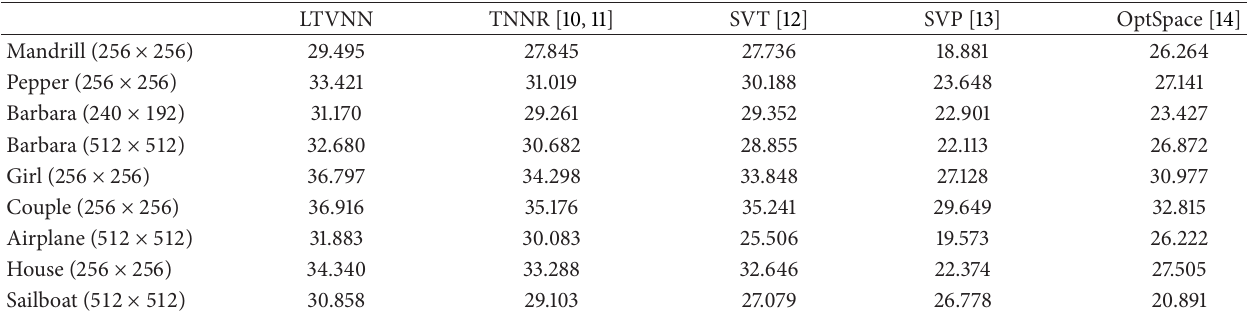
Figure 4: Comparison of PSNR of recovered methods for Lena under word mask with 𝛾 = 0.5 by LTVNN, TNNR, SVT, SVP, and OptSpace. Table 1: PSNR results under word mask sample with 𝛾 = 0.5 for different images by LTVNN, TNNR, SVT, SVP, and